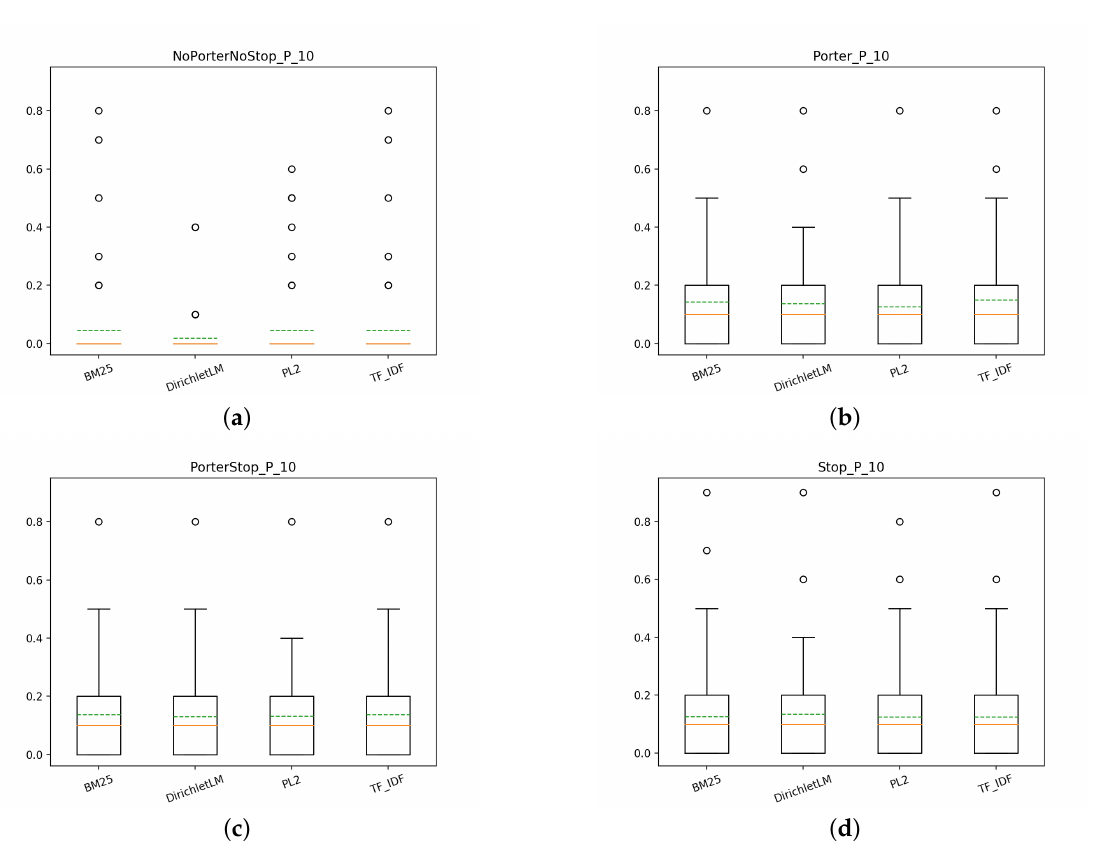
Figure 4. T1: box plots for P@10 of the different models for each index. ( a ) NoPorterNoStop index, ( b ) Porter index, ( c ) PorterStop index, ( d ) Stop